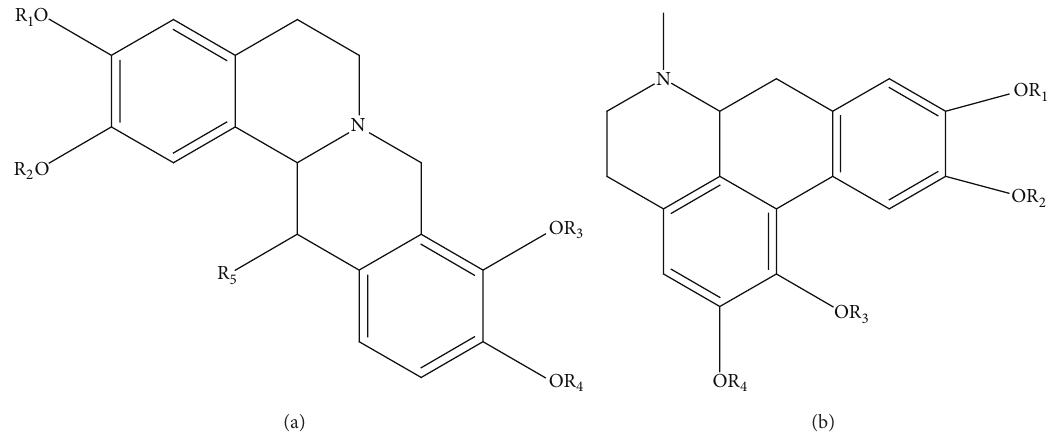
Figure 2: Two foundation formations of alkaloids in Rhizoma Corydalis. (a) Corydaline: R =R =CH . CH 2 –; R 3 4 3